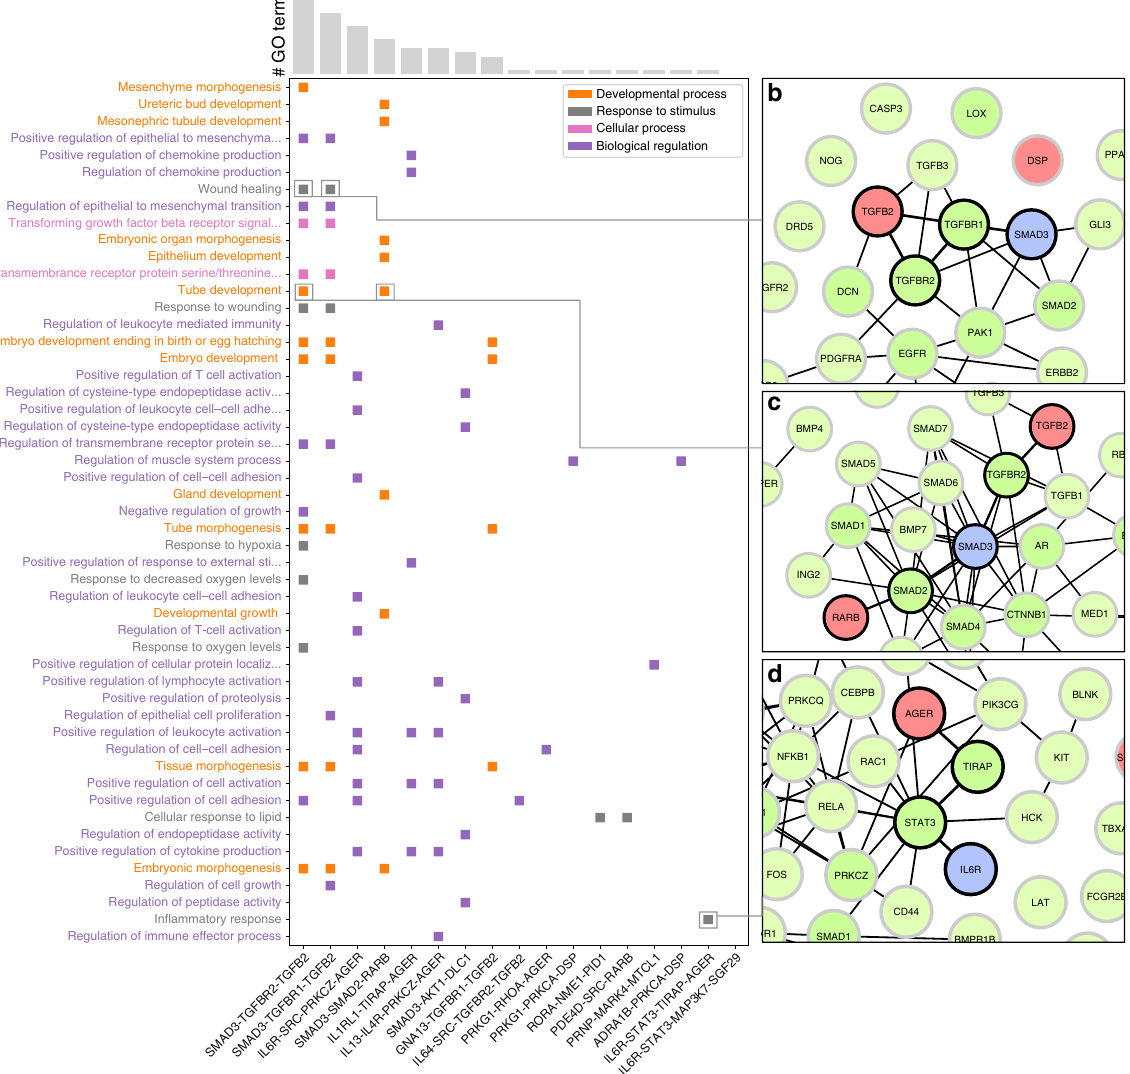
Fig. 3 Top 50 biological process GO terms. Top 50 biological process GO terms enriched in fl ow central paths, ordered by information content, and top 17 FC paths ordered by number of GO annotations. a Squares indicate that the GO term on the left is annotated to all the genes in the FC path on the bottom. Different colors indicate different subclasses of the biological process category; b – d examples of paths corresponding to selected GO